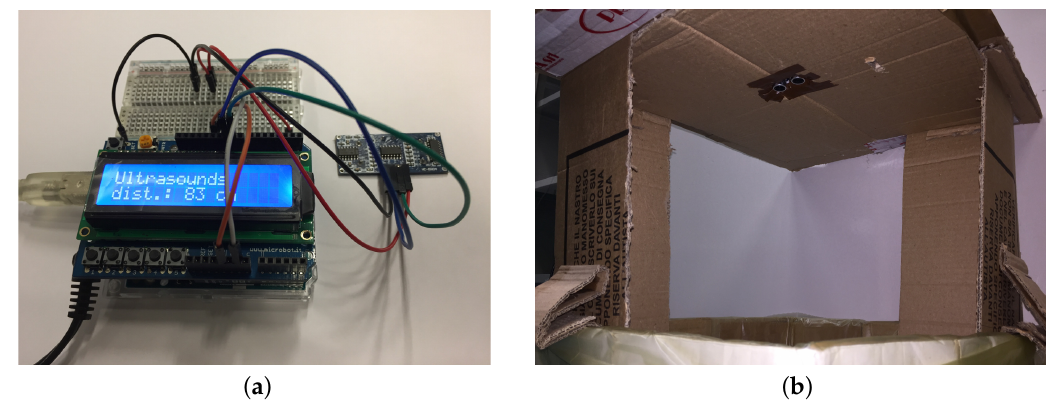
Figure 8. Experimental setup: ( a ) the LCD screen showing a measured distance value; ( b ) the ultrasound sensor placed in the cardboard